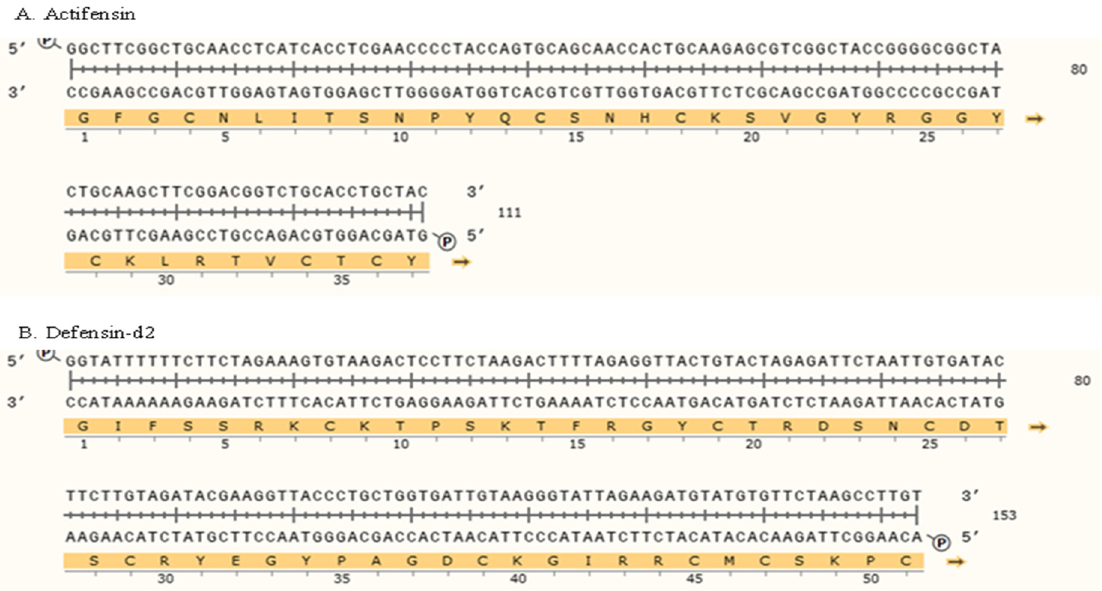
Figure 1. Schematic representation of gene constructs of ORFs encoding ( A ) actifensin and ( B ) defensin-d2, optimized to E. coli codon usage. Construct was generated using Snapgene v 1.1.3 (from Insightful Science; available at snapgene.com).